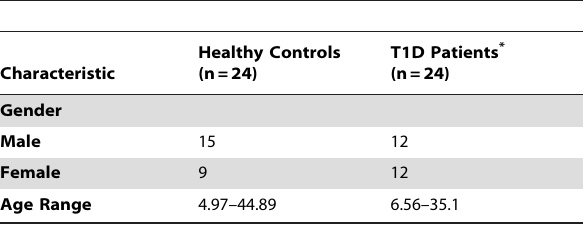
Table 2. Characteristics of patient, control and relative samples collected for CSF2 and PTGS2 sequencing